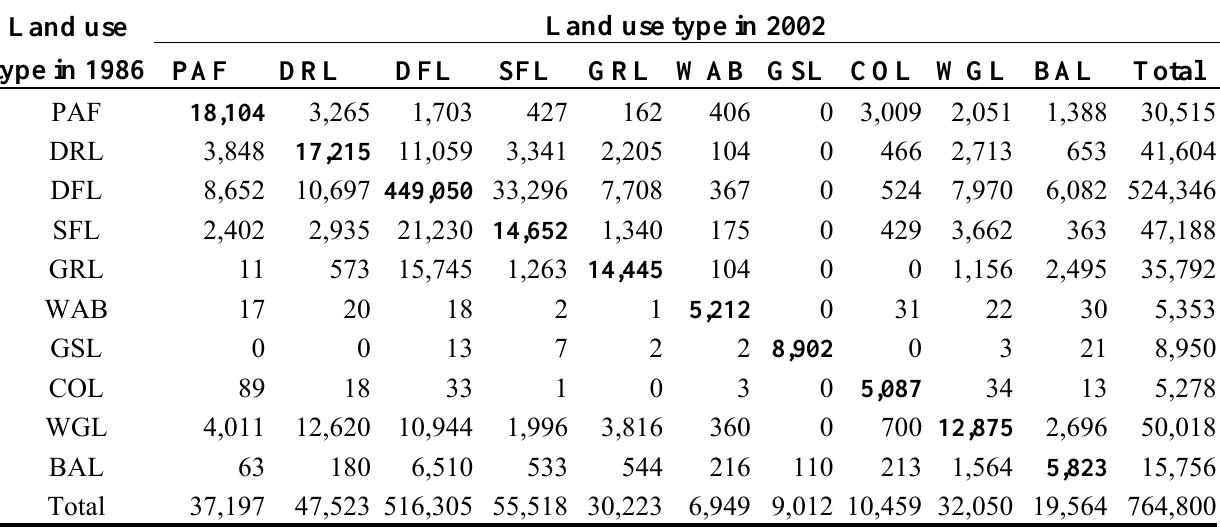
Table 2. Land use change matrix in Lijiang County during 1986-2002 (ha). Land